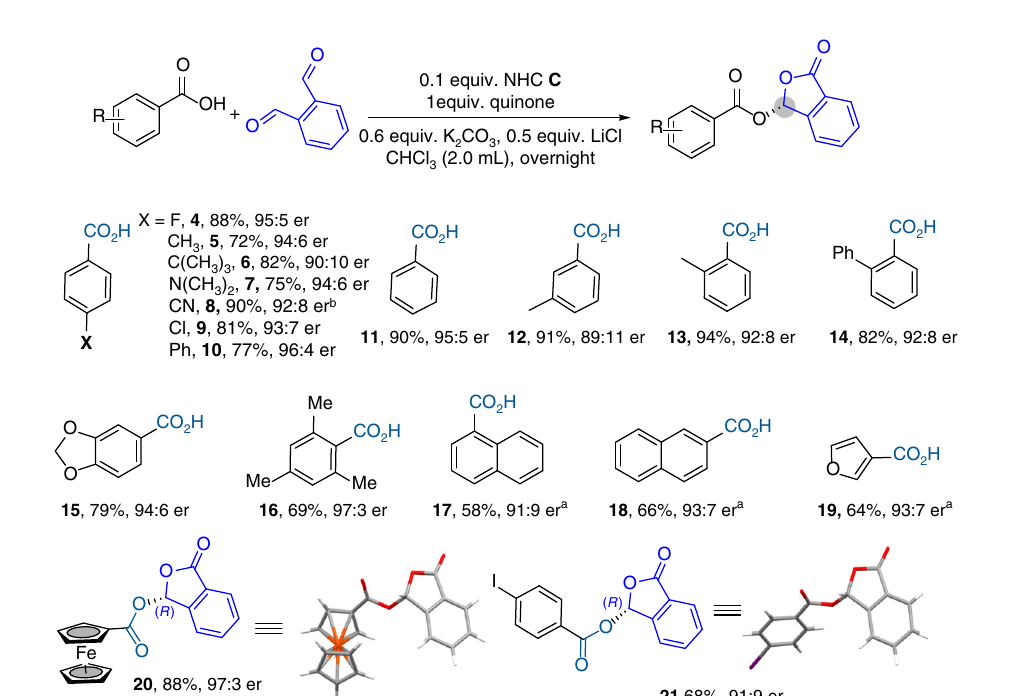
Fig. 2 Scope of aromatic acids. Reaction conditions: aromatic acid (0.1 mmol), o -phthalaldehyde (0.15 mmol), 0.1 equiv. NHC C , 1 equiv. quinone, 0.6 equiv. K 2 CO 3 , 0.5 equiv. LiCl, CHCl 3 (2 mL), rt, 12 h. Yields determined by isolation. er determined by HPLC. a under − 30 °C. b toluene as solvent